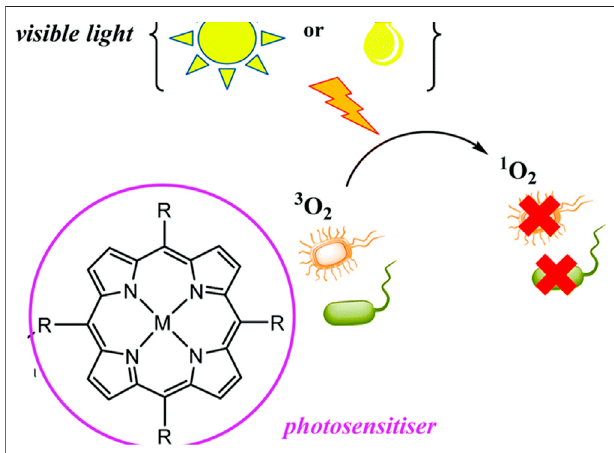
FIGURE 1 | Production of ROS by porphyrins and application in PACT. The illustration shows a generation of singlet oxygen upon irradiation by light which leads to microorganism destruction. Adapted with permission from Spagnul et al.